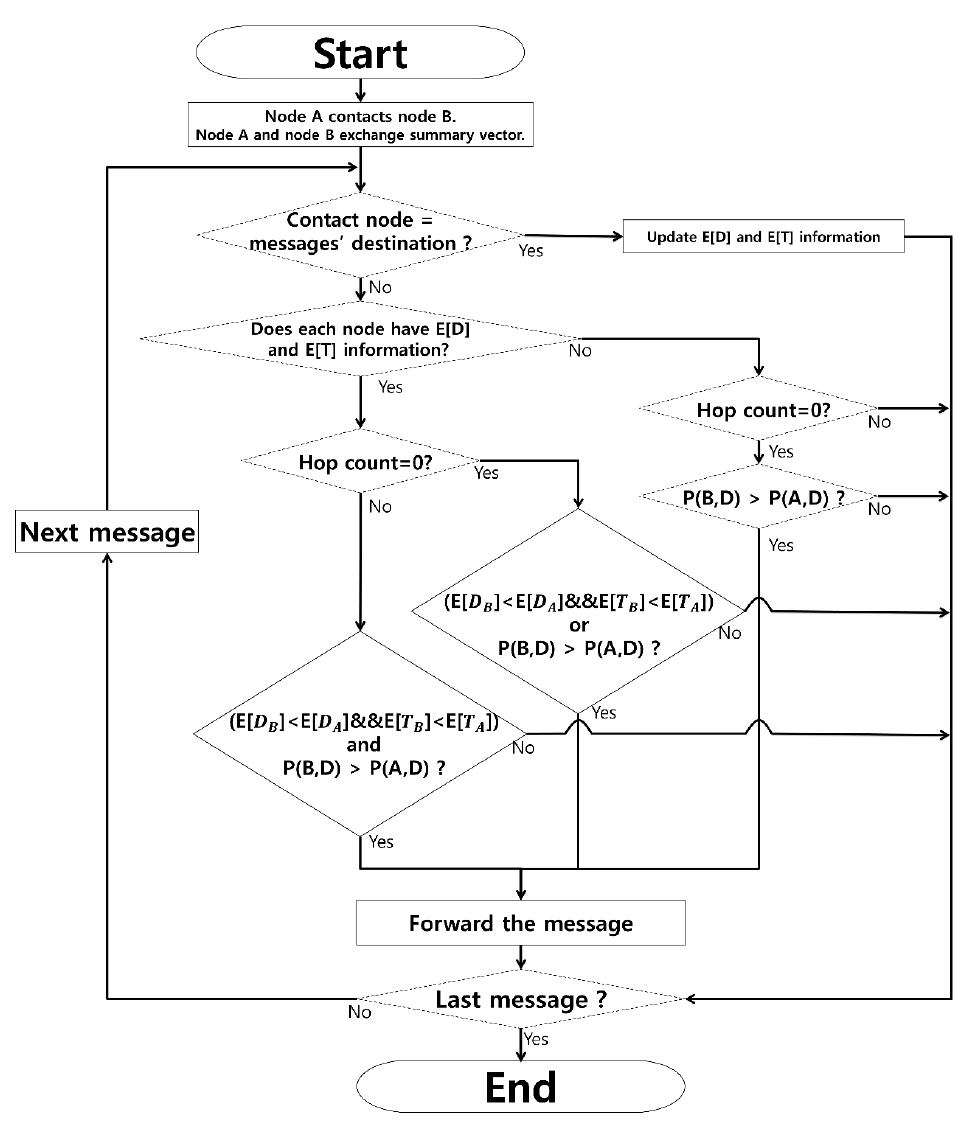
Figure 3. Flowchart of the proposed protocol.